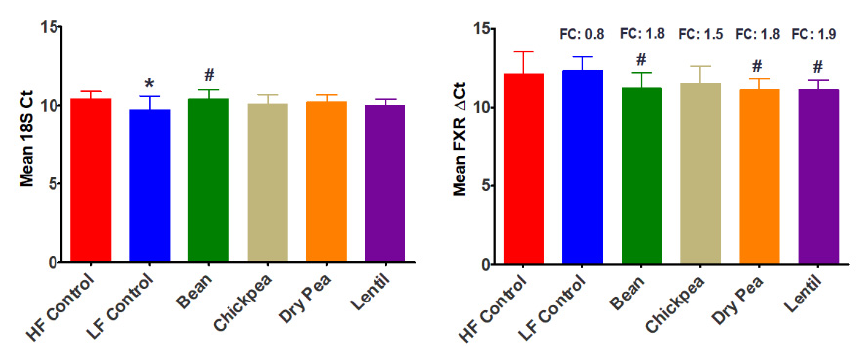
Figure 3. Farnesoid X Receptor (FXR) expression. ( A ) 18S Ct, ANOVA: LF Control p = 0.0268, Bean p = 0.9537, Chickpea p = 0.3215, Dry Pea p = 0.5767, Lentil p = 0.2114; ( B ) FXR ∆ Ct, ANOVA: LF Control p = 0.6239, Bean p = 0.1225, Chickpea p = 0.2717, Dry Pea p = 0.1044, Lentil p = 0.0787; * di ff erent relative to HF Control ( p ≤ 0.05); # di ff erent relative to LF Control ( p ≤ 0.05). Fold change was calculated